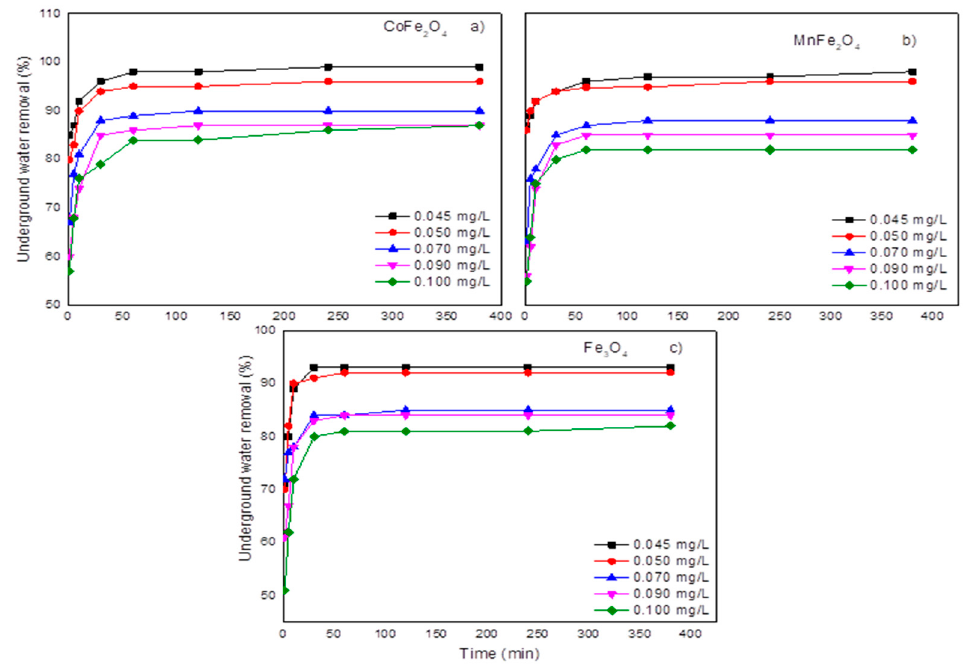
Figure 4. As removal (%), the effect of As initial concentration, ( a ) CoFe 2 O 4 , ( b ) MnFe 2 O 4 , and ( c ) Fe 3 O 4 . ( c ) Fe 3 O 4